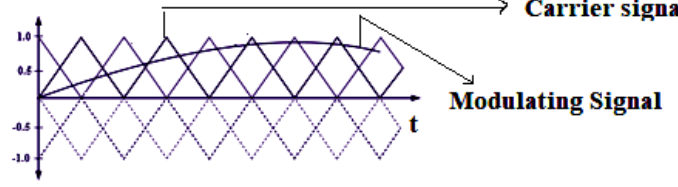
Figure 39. Modified PWM signal.